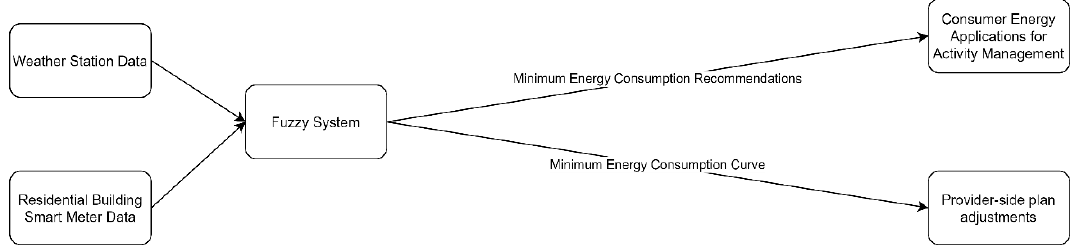
Figure 3. Potential integration of the fuzzy system as a minimum energy consumption recommendation tool for consumer applications or as a secondary analysis tool for provider-side adjustments complementing the load curve.